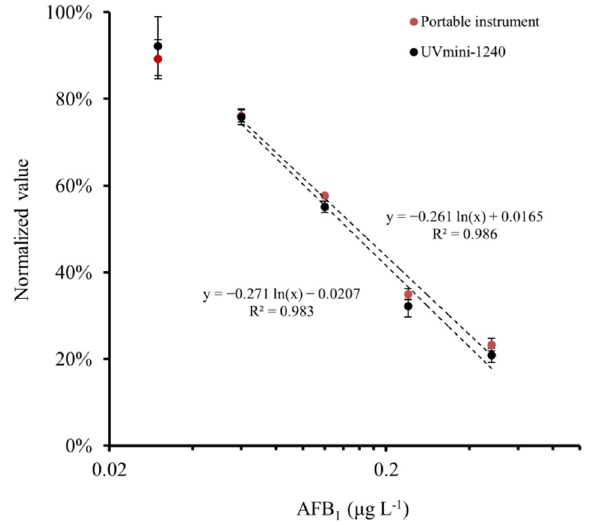
Figure 5. Calibration curve for AFB 1 obtained by both the portable instrument and the professional spectrophotometer ( n = 4).